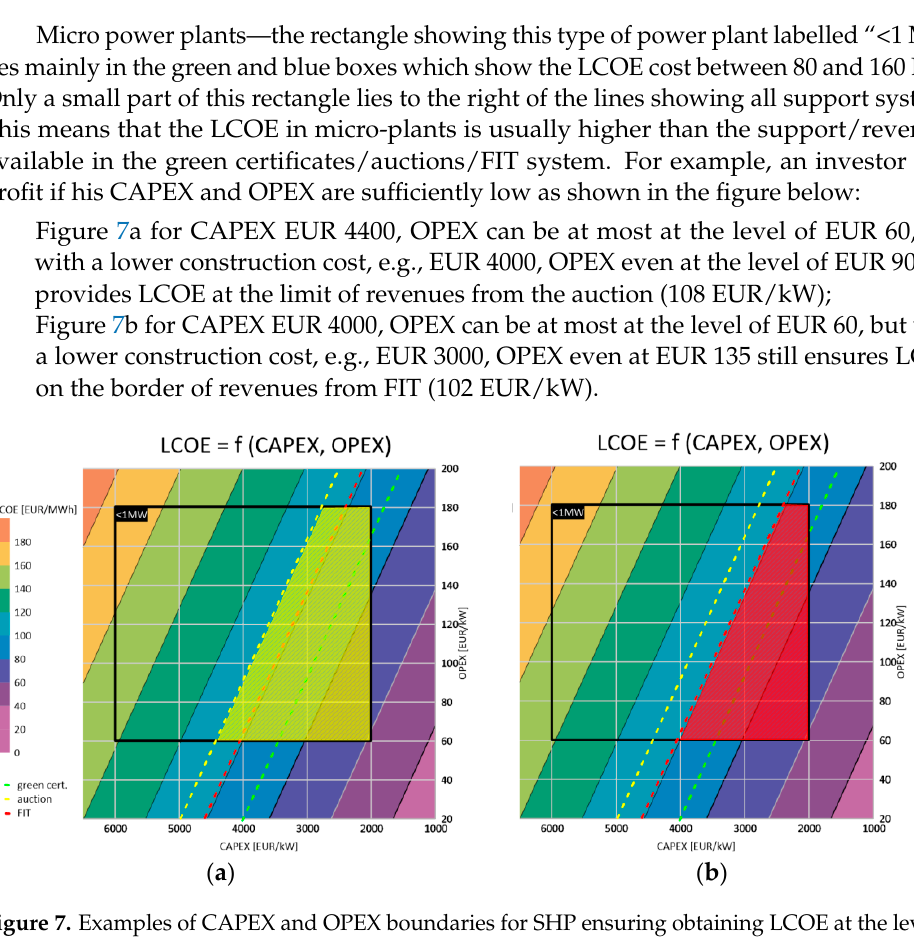
Figure 8. The total cost LCOE and possible revenues from support systems (green certificates, auc ‐ tions, FIT), analysis period 15 years, capital costs 7%. Source: own elaboration. Shortening of the analysis time, which means for an investor the shortening of the capital return time up to 15 years, results in a substantial increase in the LCOE. Micro and small hydropower plants hardly have the ability to reach this level of LCOE. This means